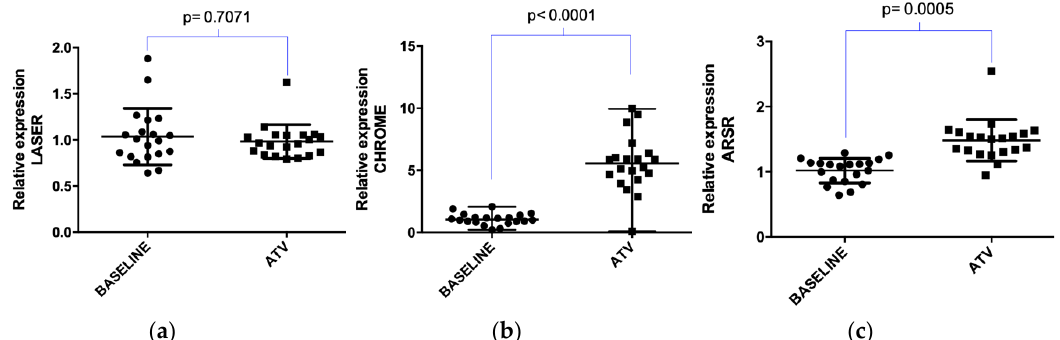
Figure 2. Expression of lncRNAs in hypercholesterolemic (HC) patients treated with atorvastatin: ( a ) LASER expression; ( b ) ARSR expression; and ( c ) CHROME expression. Relative quantification was performed by real-time PCR from total RNA extracted from leukocyte cells of peripheral blood from HC patients before (baseline) and after treatment with atorvastatin (ATV, 20 mg/day/4 weeks). p - value was obtained by paired t- Test. Normalization was performed using small nuclear RNA U6 (U6) as a reference gene.